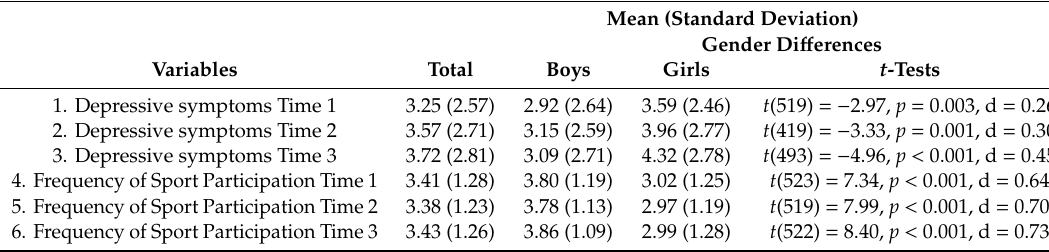
Table 1. Descriptive statistics and gender di ff erences.